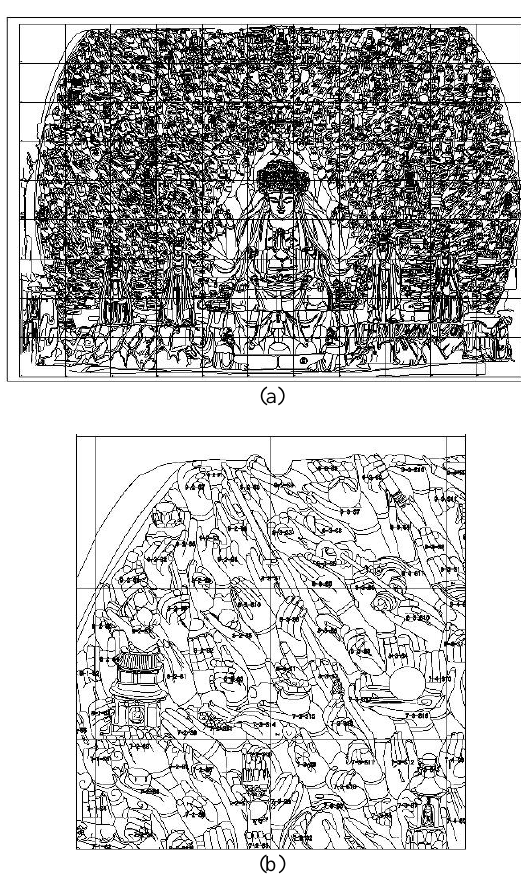
Figure 4 . The line drawing of Dazu thousand-hand bodhisattva